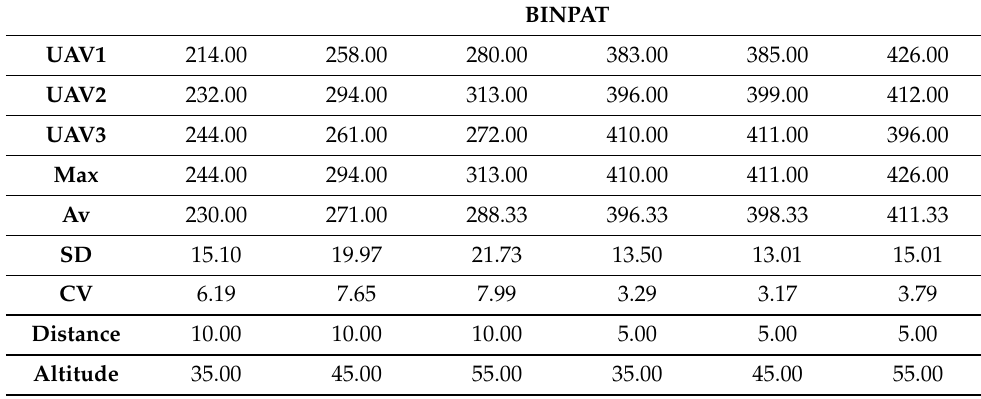
Table A2. Time results using the BINPAT algorithm and three UAVs in a short-track scenario.